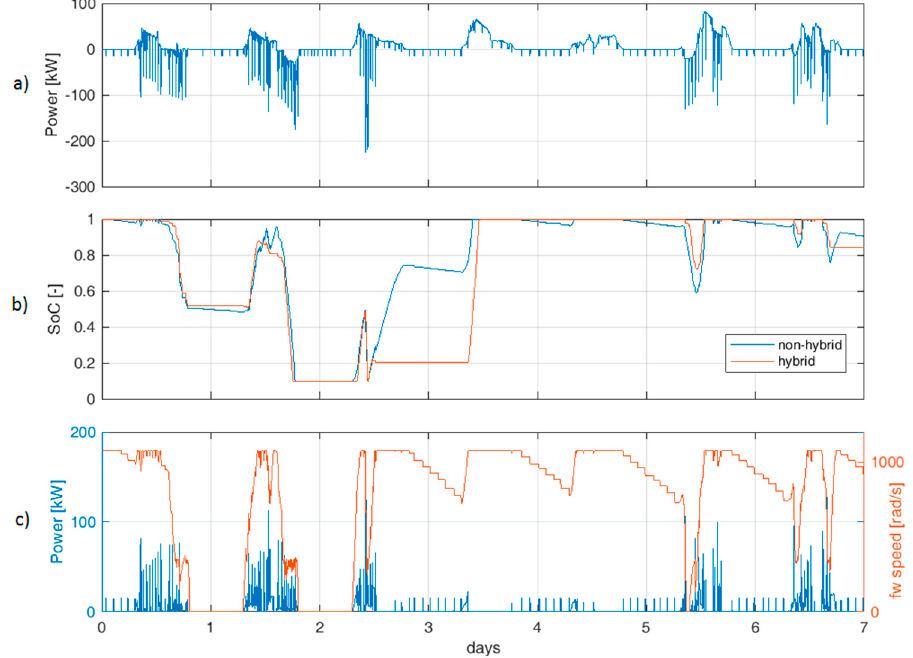
Figure 4. Main assessed parameters for configurations 1 (hybrid) and 2, respectively: a ) power difference between PV production and 𝑳 𝑲𝒊𝒕 load profile, b ) battery SoC in hybrid and non-hybrid 𝒊𝒏𝒅 cases, c ) flywheel power (absolute value) and speed (hybrid case)